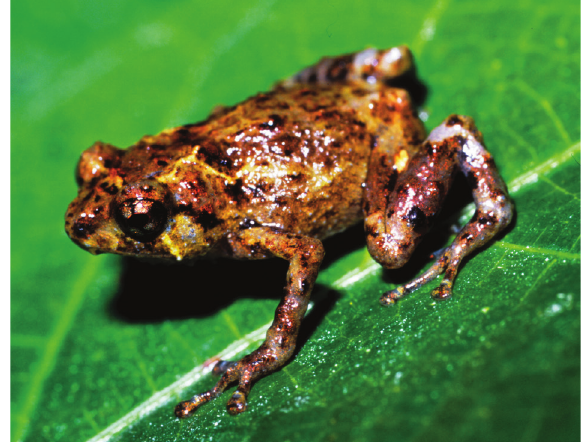
Figure 6. Paratype PNGNM unreg. (=FN SJR2137) of Choero- phryne multisyllaba sp. n. in life.